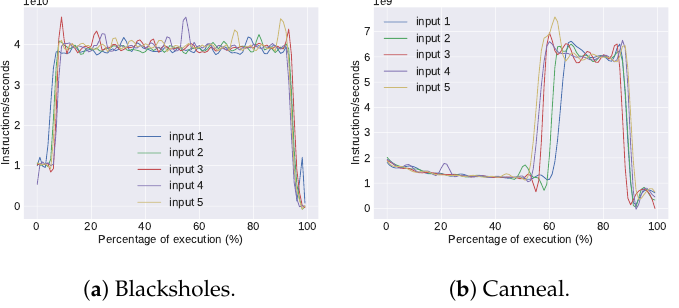
Figure 5. Rate of instructions per second varying the input size normalized by the